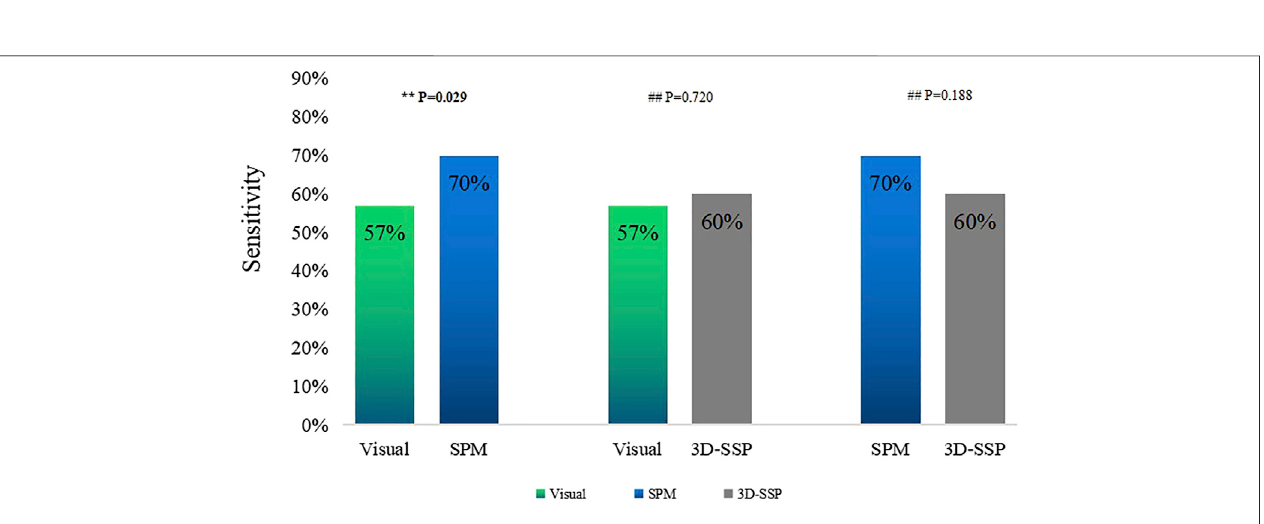
Frontiers in Bioengineering and Biotechnology |